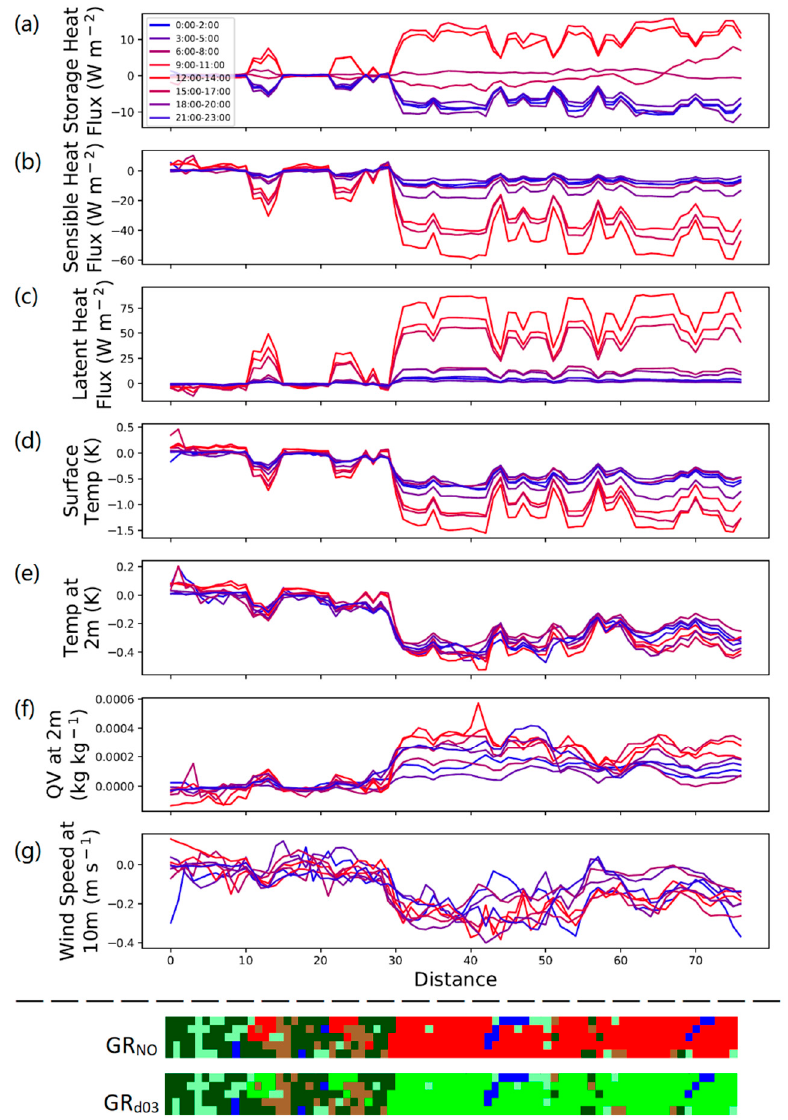
Figure 11. The same as Figure 6, but between GR d03 (green roofs added to all roofs in the d03 urban grids) and GR NO (no green roofs) scenarios (Section 2.5).